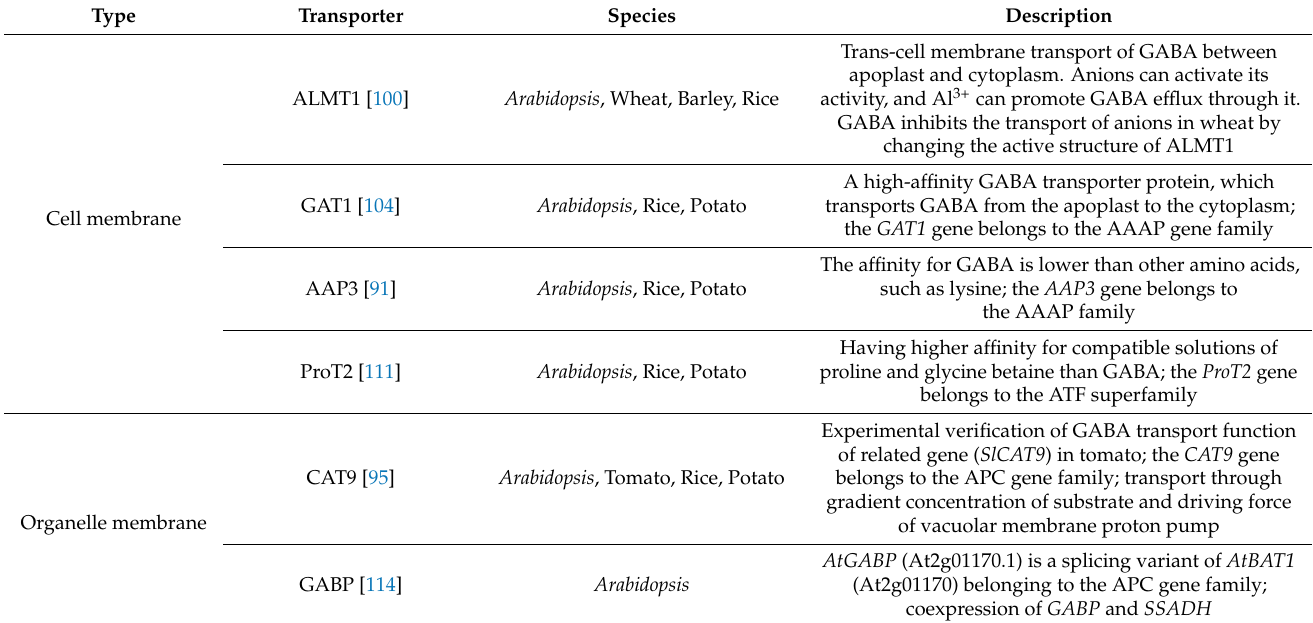
Table 2. GABA transport protein in